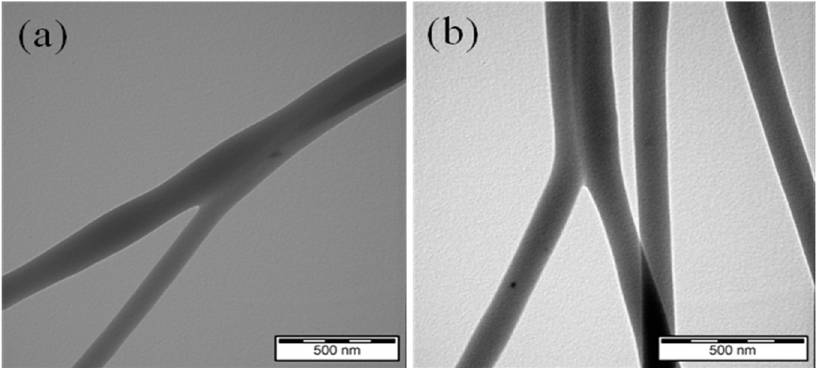
Figure 2. TEM micrograph of electrospun pure PCL ( a ) and PCL/125%DSS ( b ) fibrous mats.